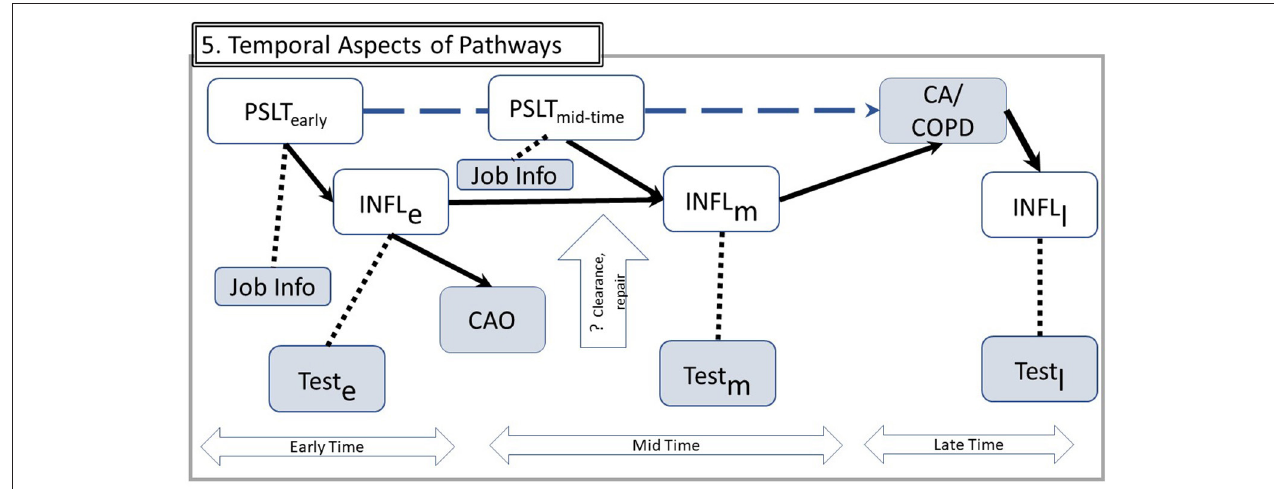
FIGURE 5 | Temporal aspects of pathways. Using example from Figure 4A , the implications for observable data over time are illustrated. Time is divided in three eras: Early exposure, Mid for subsequent years of work, and Late after the disease outcome has been diagnosed. Inflammation processes in these three eras may involve different mechanisms, denoted by subscripts e, m, and l. Since INFL is not directly observable, it is assessed by relevant tests in each of these three times. The vertical open arrow indicates that some mechanisms such as particle clearance or repair mechanisms may be specific to one time era (e.g., some particle burden from early exposures may be cleared and therefore reduce transition from early to mid-inflammation). A hypothetical from PSLT to CA/CAO is shown by the dashed upper arrow. Other abbreviations are the same as in Figure 1 .